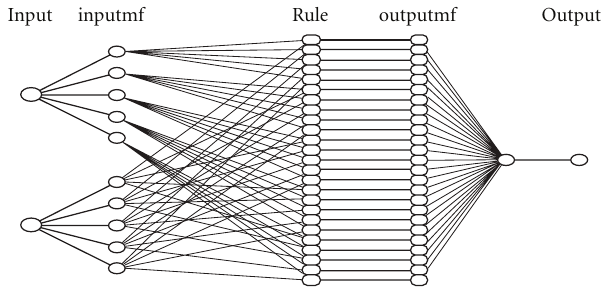
Figure 9: Internal layer of GA ANFIS model.